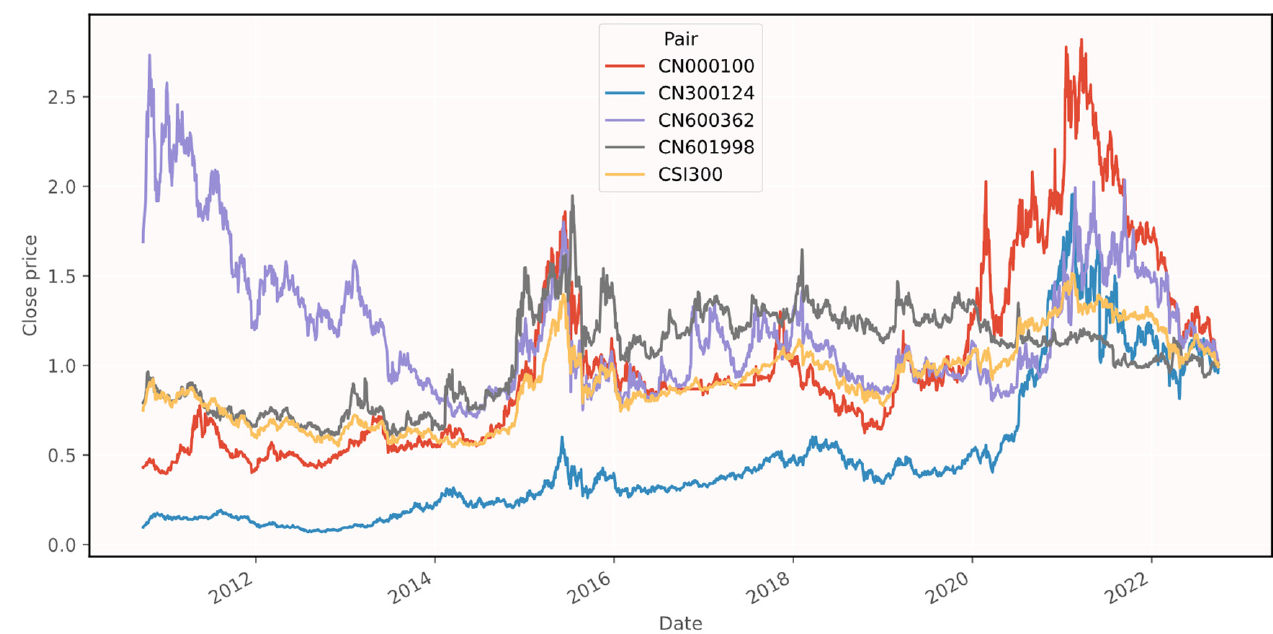
Figure 6. The closing price changes of Portfolio